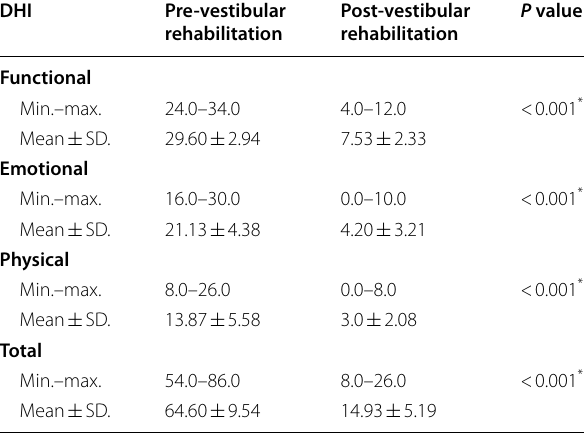
Table 1 Comparison of DHI scores before and after vestibular